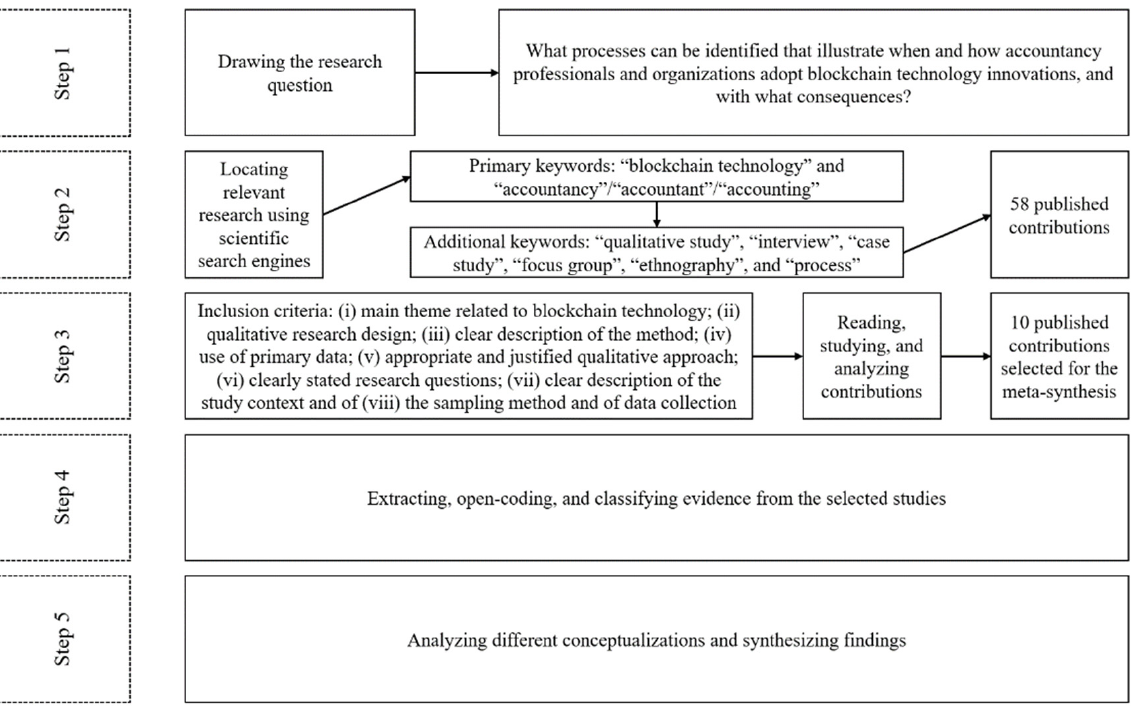
Figure 1. The five methodological steps of meta-synthesis.